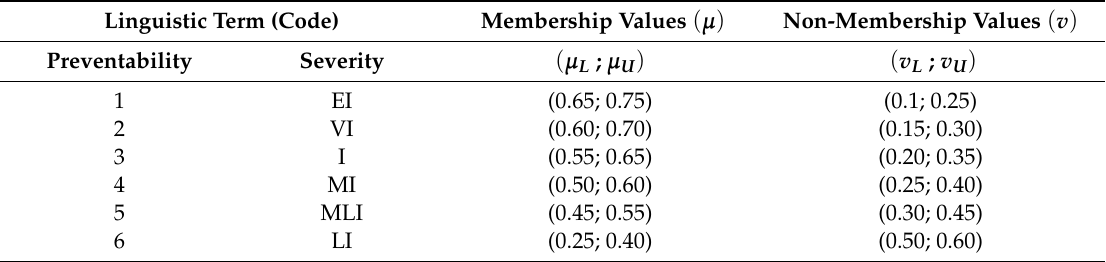
Table 4. Linguistic Terms for Preventability and Severity with Corresponding Interval-Valued Intuitionistic Fuzzy Sets (IVIFs) (Adapted from